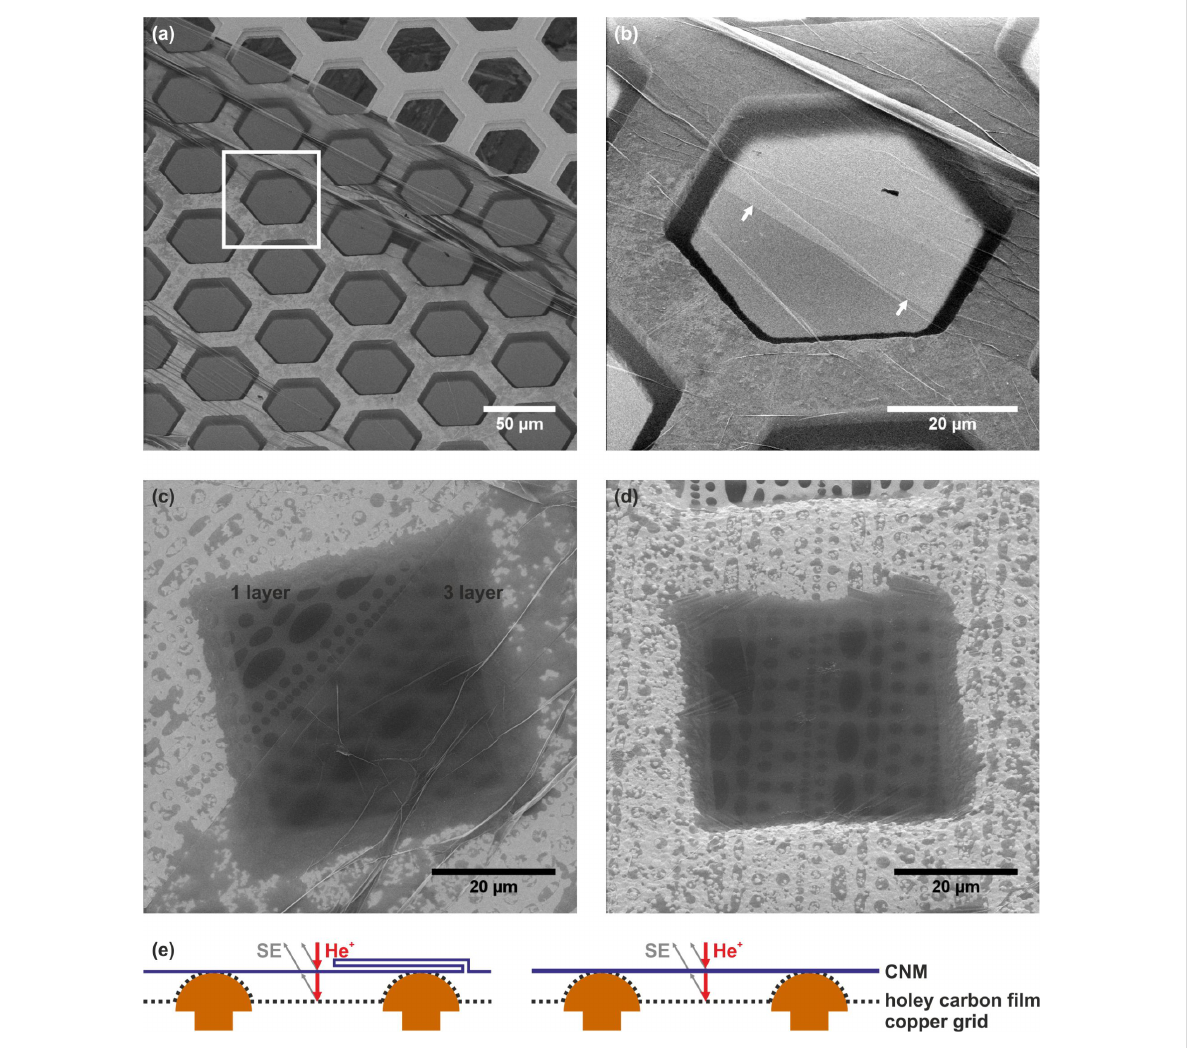
Figure 4: CNMs transferred on (a,b) bare copper TEM grids and (c,d) on grids with carbon films with regular openings (quantifoil multi-A). (b) A magnified image of the highlighted area in (a). (c,d) Increasing CNM thickness leads to more scattering of the He beam. The thickness of a single CNM layer is 1.1 nm in (c) and 1.7 nm in (d) [26]. (e) Schematic cross section of the samples in (c) and (d). The triple-layer region is folded according the scheme, which is consistent with the observed existence of a single-layer CNM on both sides of the fold. Detailed information on all HIM images is given in Supporting Information File 1, Tables S1 and